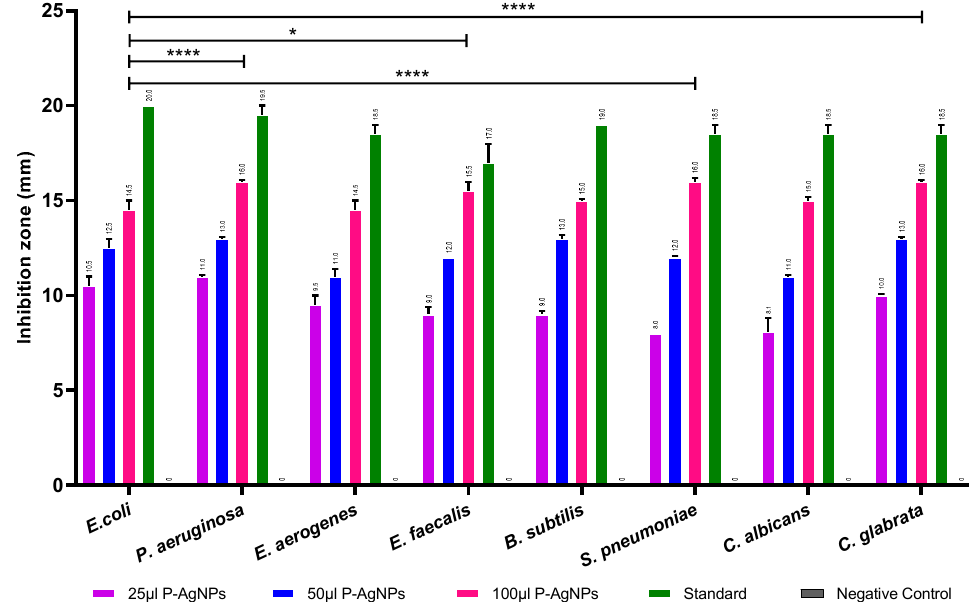
Figure 10. Antimicrobial activity of synthesized P-AgNPs against pathogenic microorganisms. Two- way ANOVA with multiple comparisons was performed to identify differences between groups. p < 0.05 (*), p < 0.001